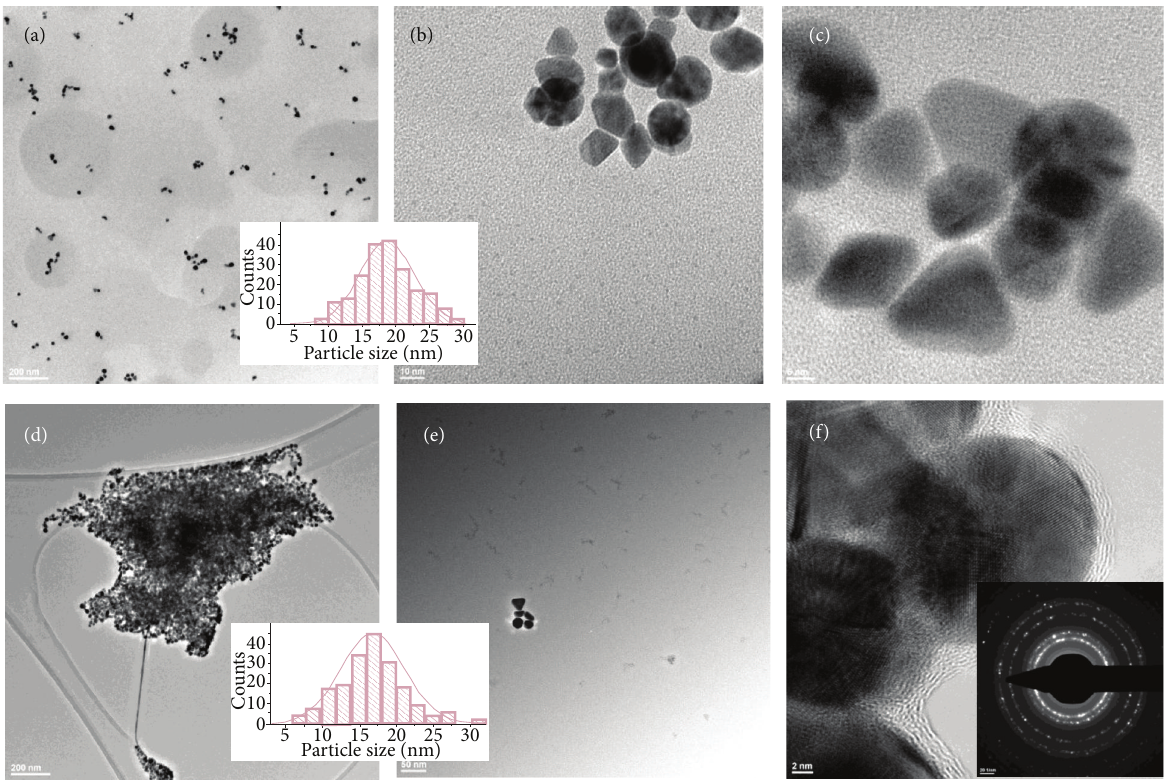
Figure 8: TEM and HR-TEM micrographs characteristic for Au-G6-5 at 60 minutes ((a)–(c)) and 48 hours ((d)–(f)), respectively, after preparation. (a) General appearance of not-yet agglomerated nanoparticles; (b) spheroid and irregular nanoparticles and gold accumulating in the intermolecular space (black arrows); (c) detailed view of crystalline nanocomposites; (d) nanoparticles forming a cluster after 48 hours after their synthesis; (e) few nanoparticles and low concentrations of metal (zoomed area is indicated in black rectangles); (f) HR-TEM micrograph of polycrystalline spherical nanoparticles, with organic layer at the periphery and SAED as an inset. Size-distribution histograms are